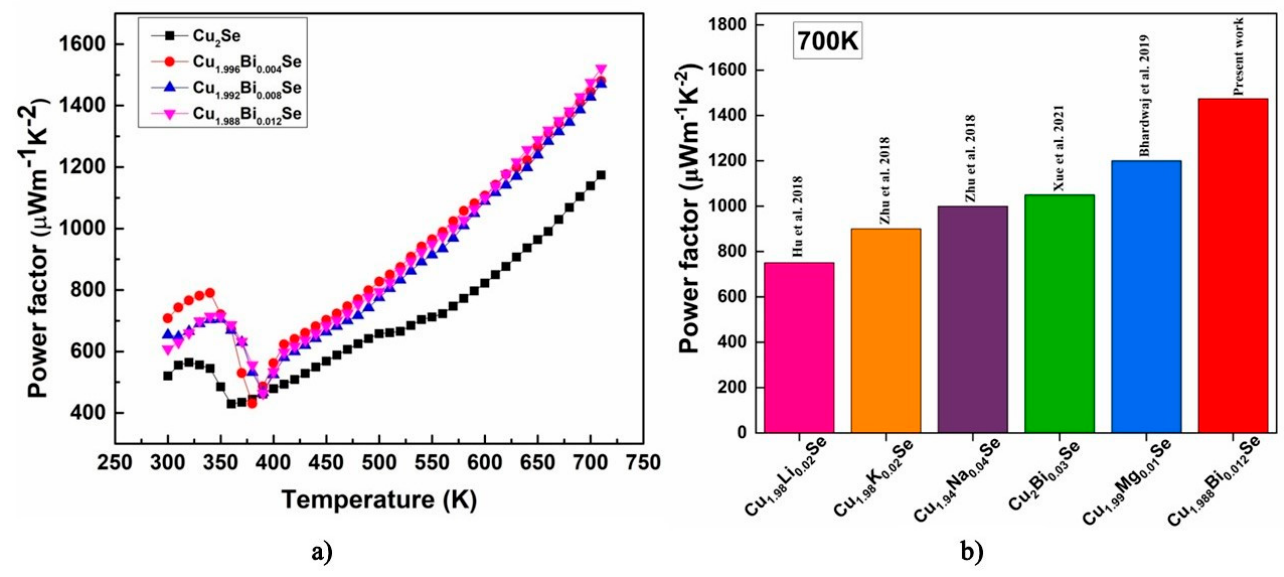
Figure 11. ( a ) Temperature-dependent Power factor for Cu 2 − x Bi x Se (x = 0.00, 0.004, 0.008, 0.012) samples, ( b ) comparison of power factor of the synthesized composition with existing literature on Cu 2 Se with different dopants [1,16–18,27].